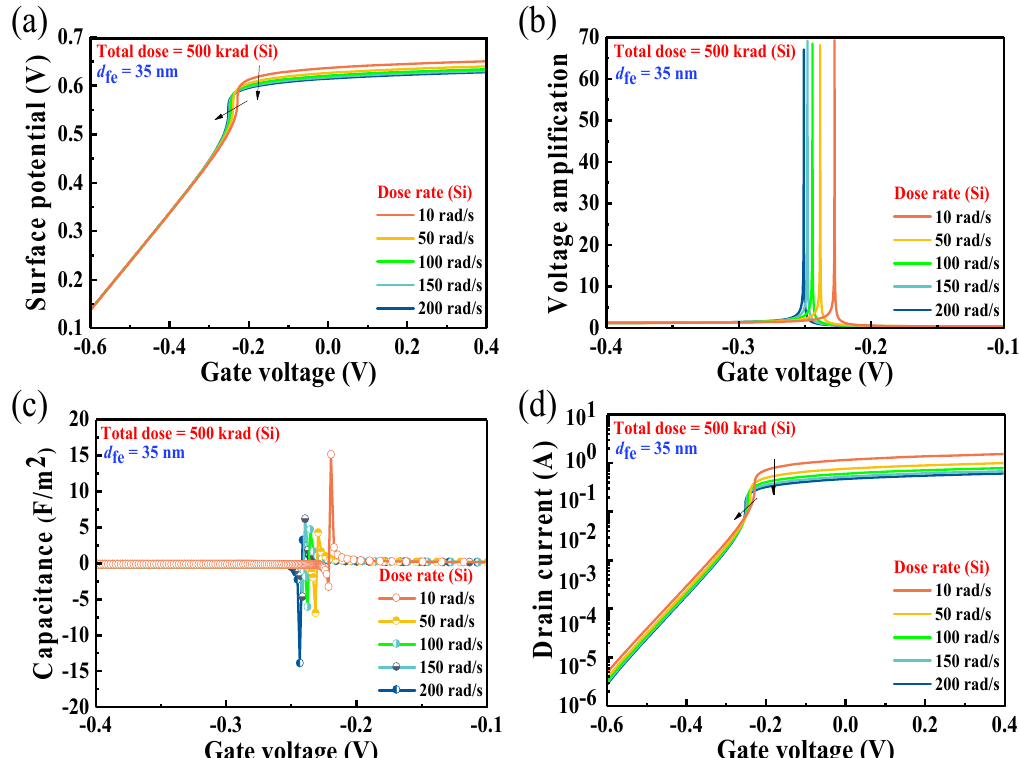
Figure 3. (Color online) ( a ) Silicon surface potential versus gate voltage, ( b ) voltage gain versus gate voltage, ( c ) ferroelectric capacitance versus gate voltage, and ( d ) transfer characteristics with different total dose rates.